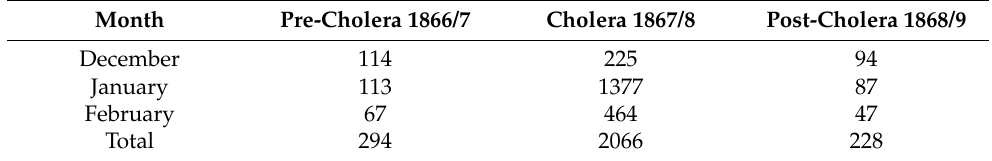
Table 1. Mortality associated with the cholera epidemic in the province of C ó rdoba from 1867 to